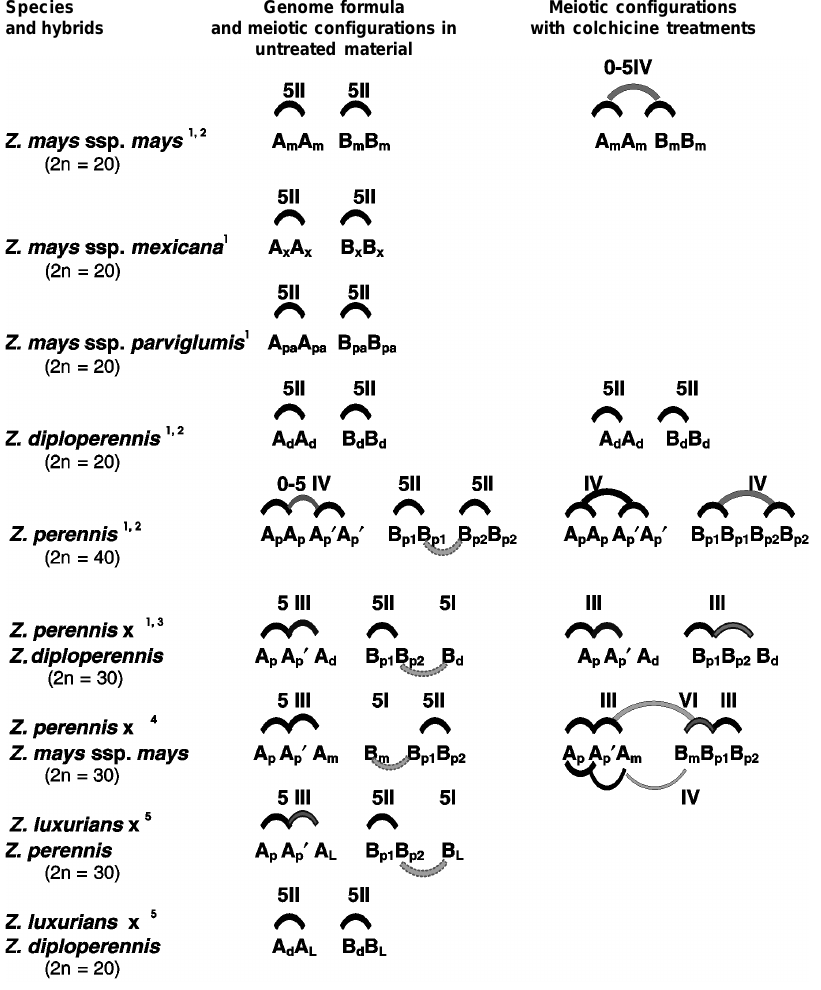
Figure 1 - Genome formulas and meiotic configurations for Zea species and hybrids with and without colchicine treatment. In untreated material: Black arcs of the top show the high-frequency meiotic association. Green arcs below indicate meiotic low frequency association. In treated material: Grey arcs indicate the new configurations that were observed and a proposed explanation for their forma- tion. Data from: 1 = Molina and Naranjo, 1987; Naranjo et al. , 1990. 2 = Poggio et al. , 1990. 3 = Naranjo et al ., 1994. 4 = Poggio, L. and Naranjo, C.A. (unpublished results). 5 = Poggio et al. , 1998; Poggio et al. ,